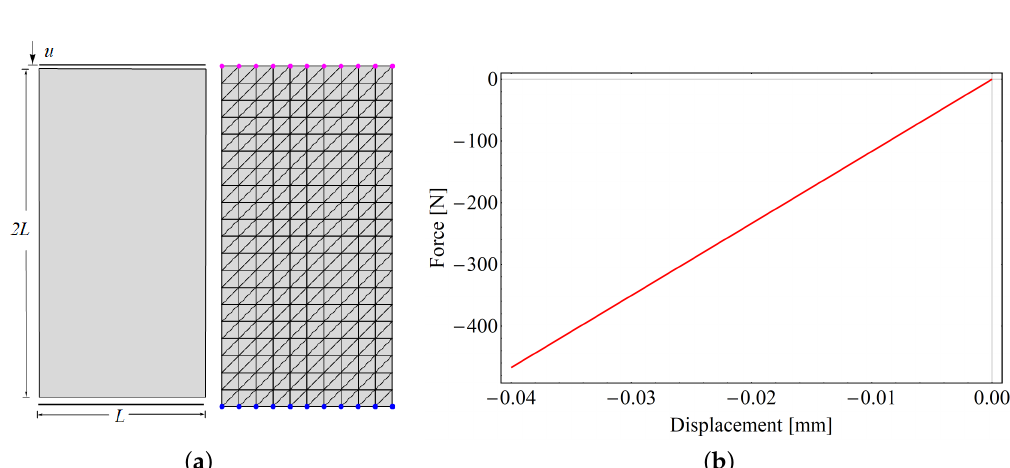
Figure 6. Compression test of a plate. ( a ) Geometry, boundary conditions, and FEM discretization. ( b ) Load–deflection curve using finite element formulation.